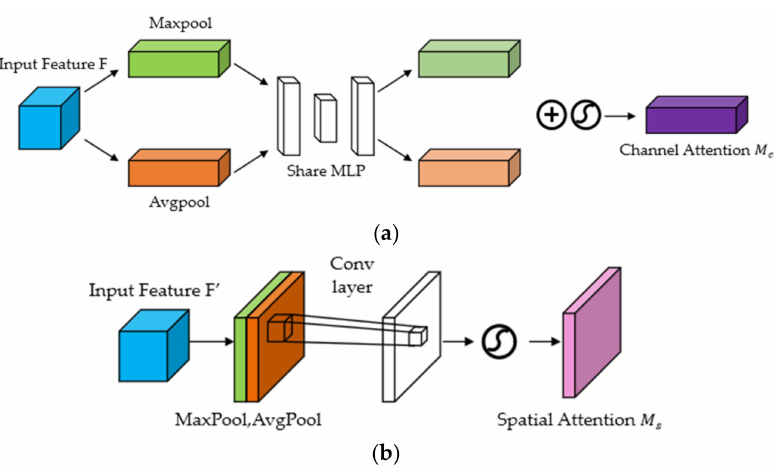
Figure 11. The architectures of the CAM and SAM modules. ( a ) SAM module. ( b ) CAM